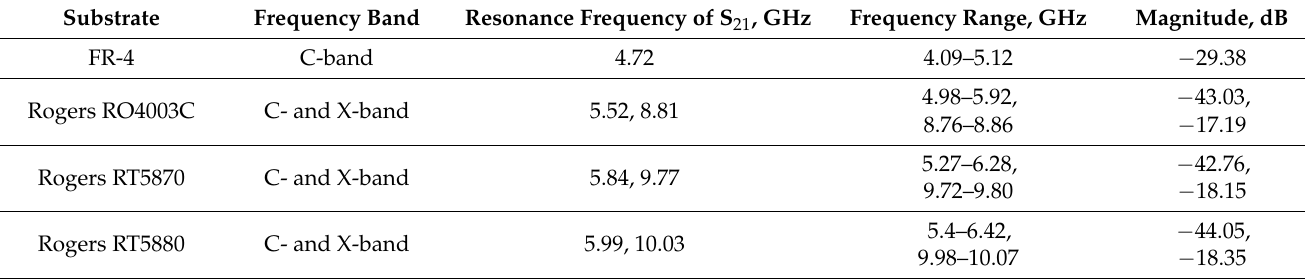
Table 3. Comparison of the S-parameters result for metamaterial structure using different